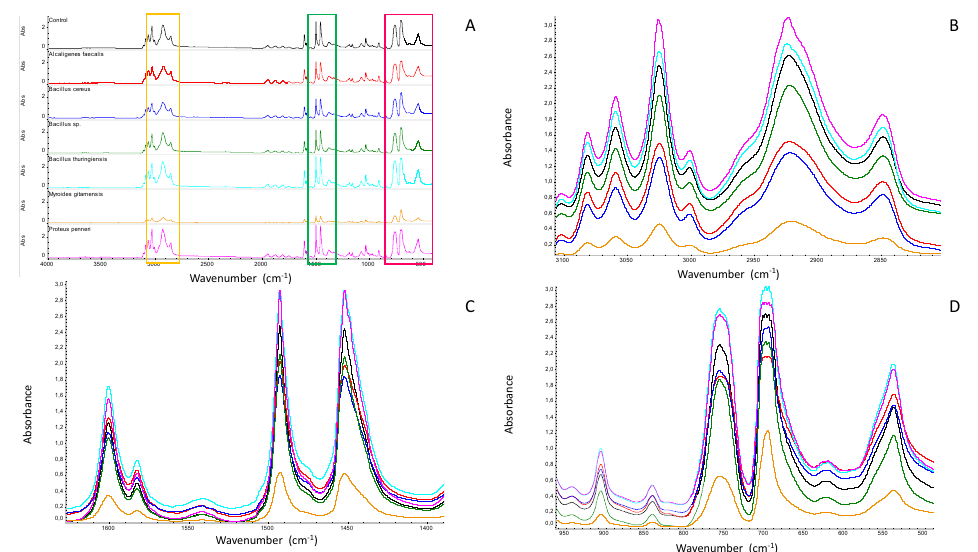
Figure 3. FTIR spectra of whole spheres of polystyrene (PS). ( A ) Spectra from polymers without inoculum (control) and with each one being bacteria inoculated; ( B ) Detail of spectra in vibration band between 3100 and 2500 cm − 1 ; ( C ) Detail of spectra in vibration band between 1600 and 1000 cm − 1 ; ( D) Detail of spectra in vibration band between 1100 and 750 cm − 1 . Red line corresponds to PS whole spheres inoculated with Alcaligenes faecalis , blue line with Bacillus cereus , green line with Bacillus sp., light blue line with Bacillus thuringiensis , orange line with Myroides gitamensis , pink line with Proteus penneri and black line corresponds to PP spheres without inoculum (control).